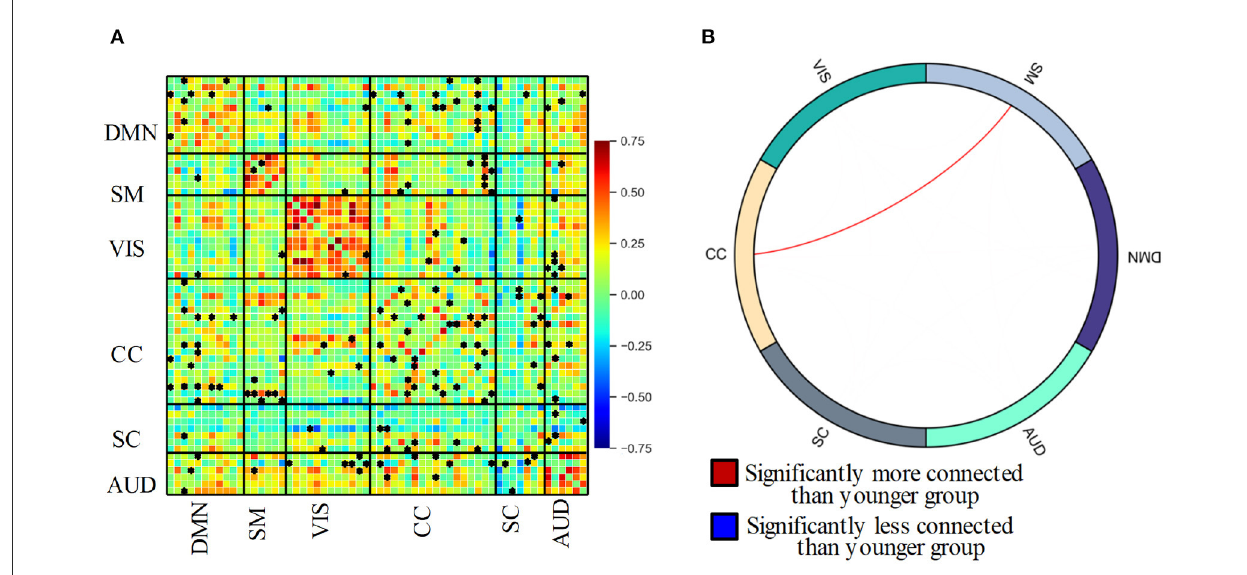
FIGURE3 (A) Static functional network connectivity between 60 independent components resulting in 1770 ( 60 × (60-1)/2 )connectivity pairs for the entire group. Asterisks indicate significant differences between the elderly and younger groups. (B) Circle plot of significant static functional network connectivity differences of 6 domain between the elderly adult and younger group.